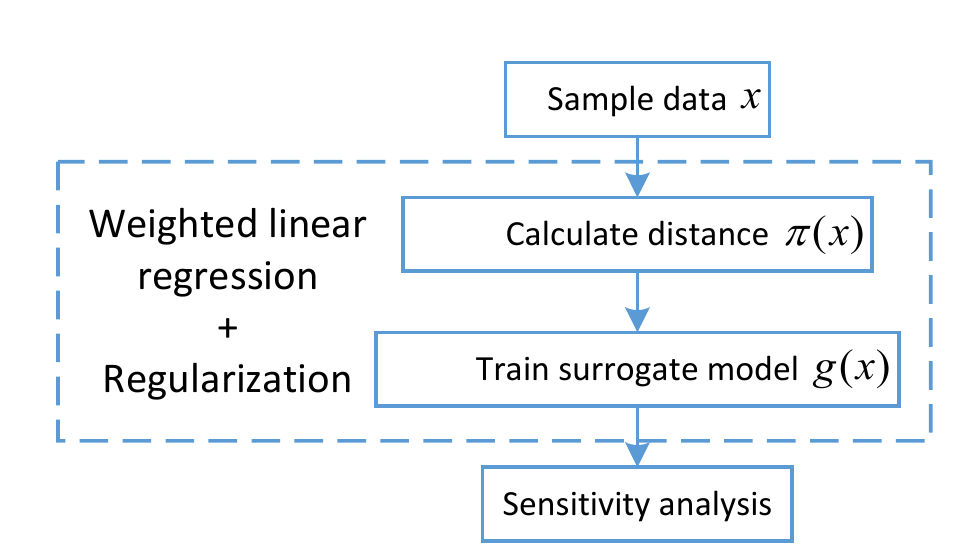
Figure 7. The process of building a local mimic model using